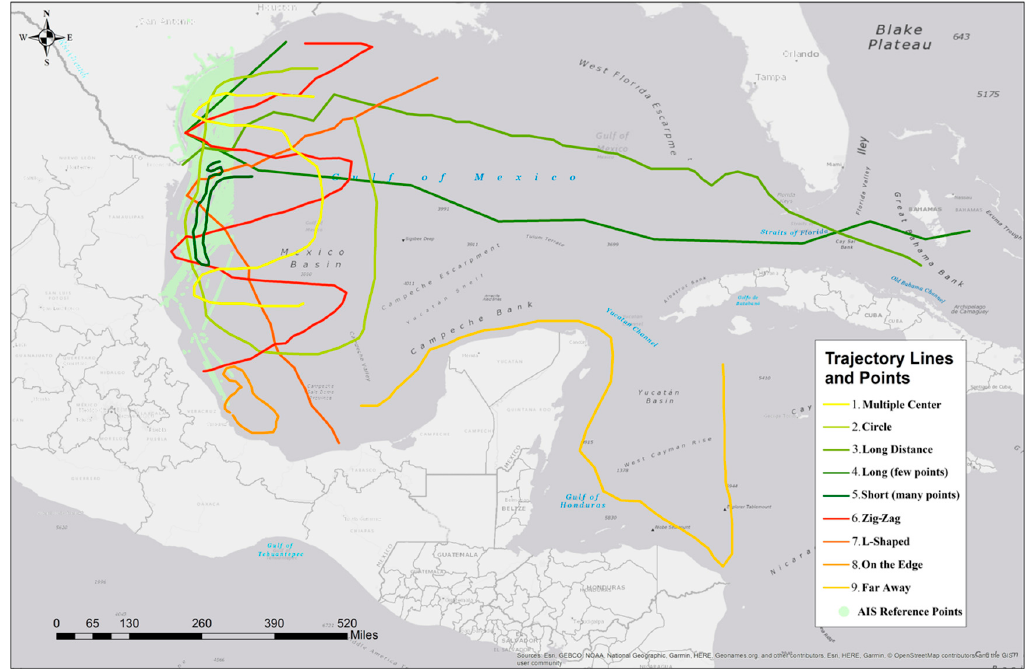
Figure 8. Distribution of query trajectories and points from reference trajectories.